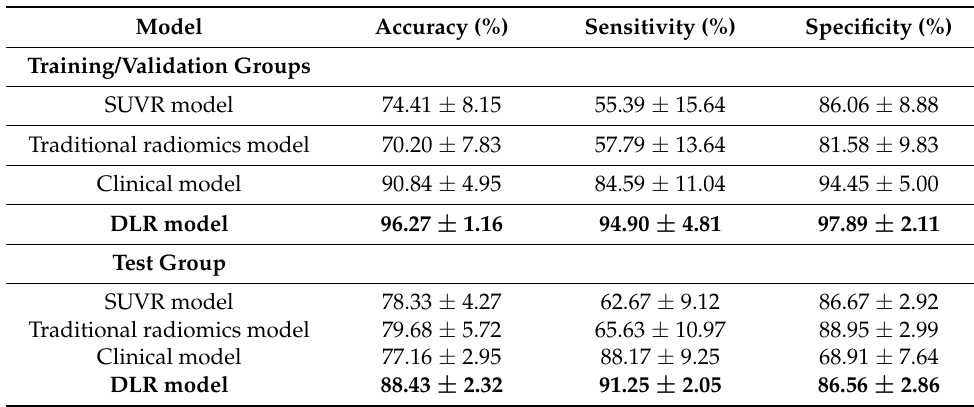
Figure 5. ROC curves for the four models in NC vs. MCI. Table 6. The classification performance in MCI vs.